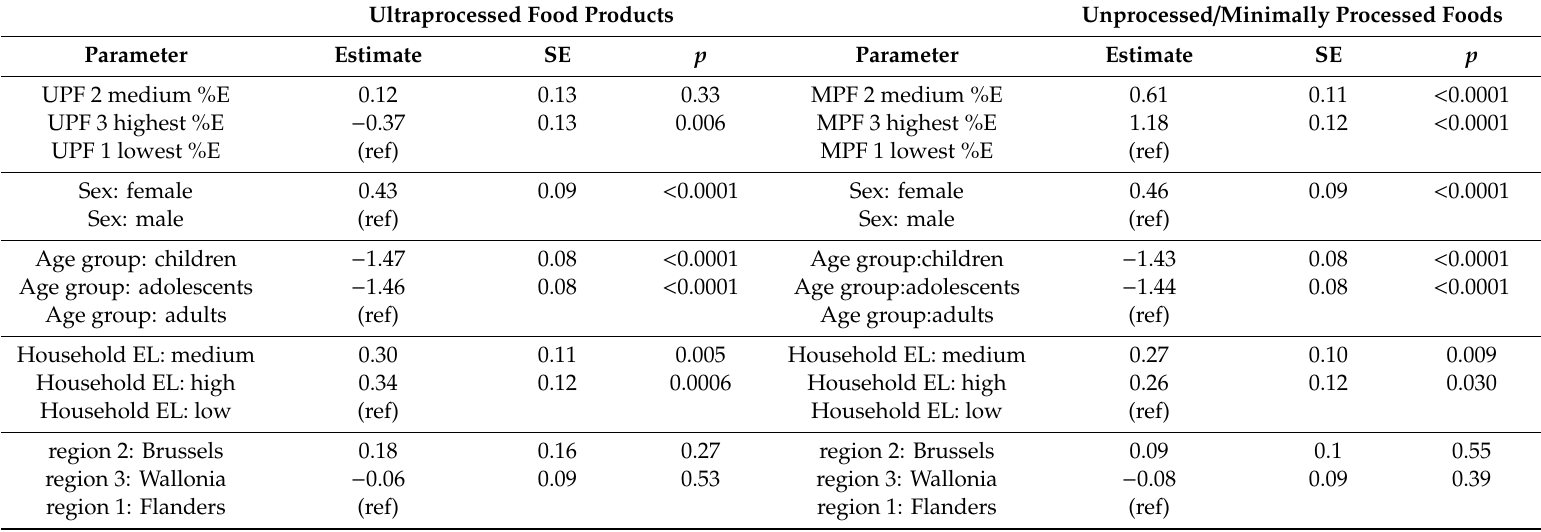
Table 2. Cost di ff erential (EUR / 2000 kcal) between diets with higher and lower proportions of energy intake (tertiles based on average over two interview / record days) from ultraprocessed foods (UPF) and minimally processed foods (MPF), adjusted for age group, sex, household education level (EL) and